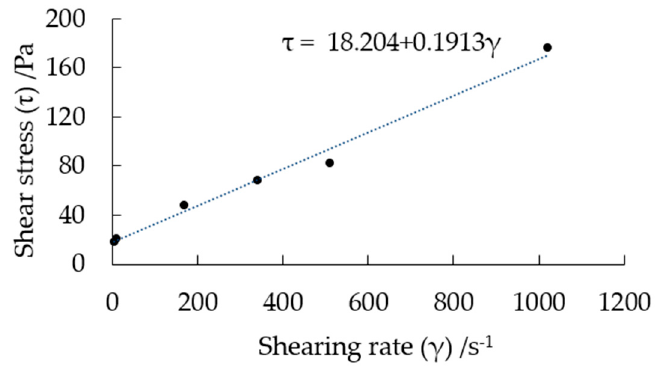
Figure 8. Rheological characteristic of cement slurry (W:C = 0.5:1).